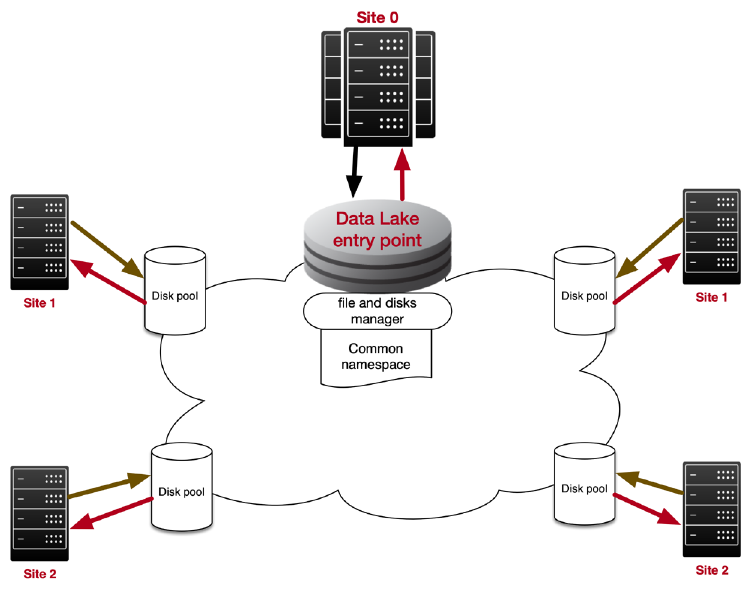
Figure 2. Proposed scheme of data transfers in the data lake prototype with the bu ff ering